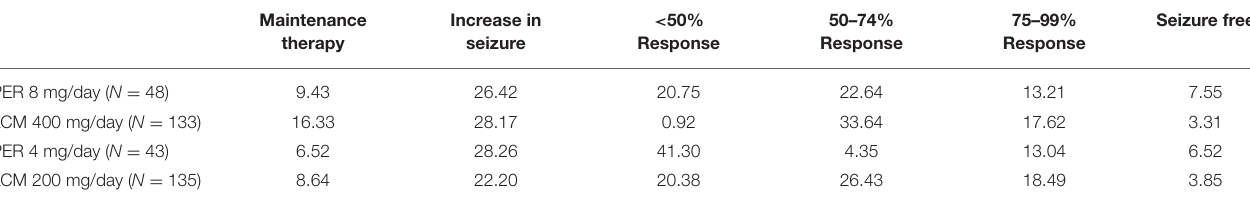
TABLE 2 | Response distribution in the first cycle, %.